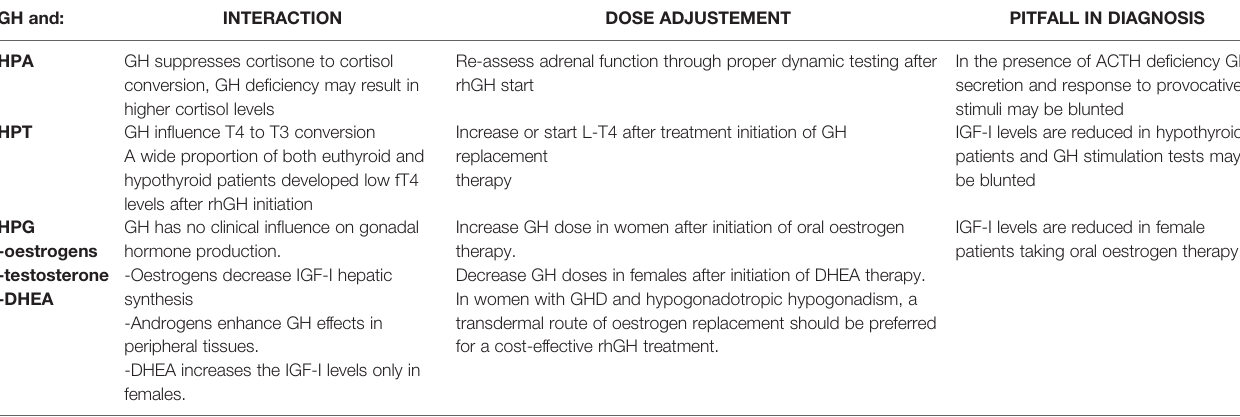
TABLE 3 | GH de fi ciency and therapy in multiple pituitary hormone de fi ciency: interactions and dose adjustments. GH and: INTERACTION DOSE